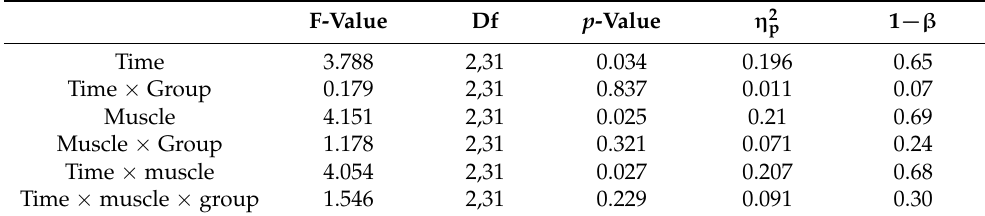
Table 4. Multivariate analysis values of left leg.